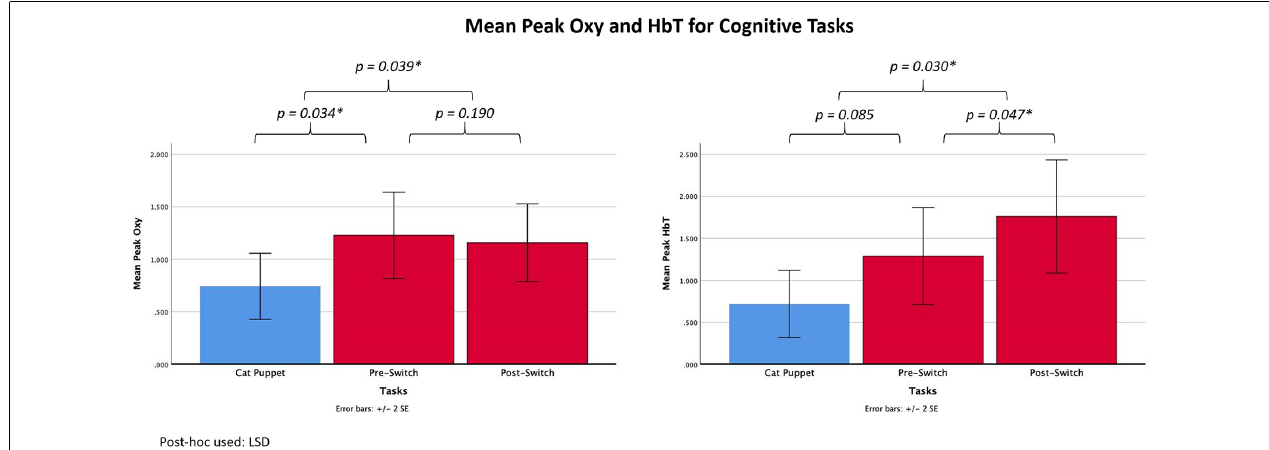
FIGURE 4 | Graphs showing mean peak Oxy and HbT for the cognitive